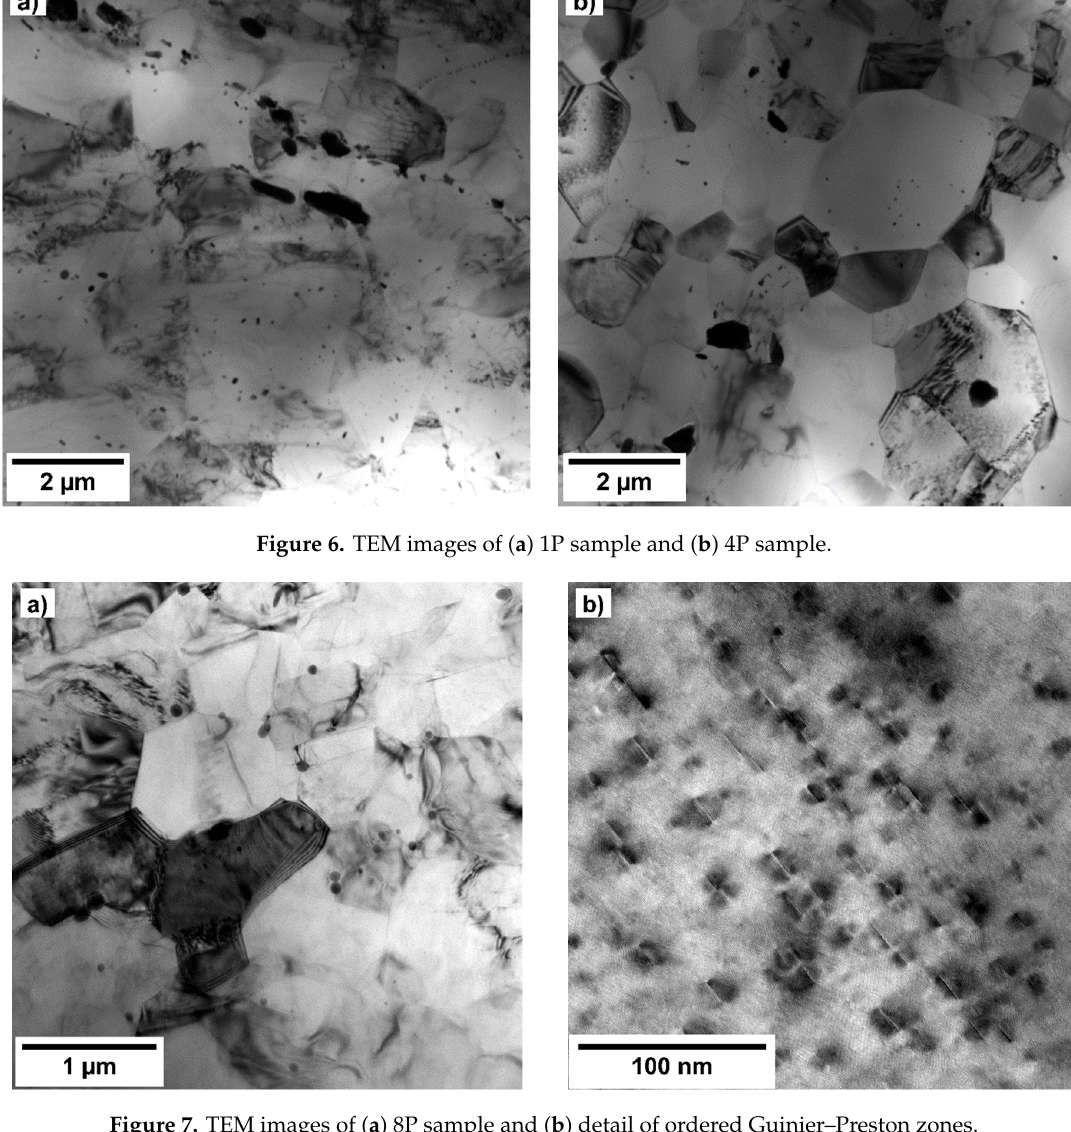
Figure 7. TEM images of ( a ) 8P sample and ( b ) detail of ordered Guinier–Preston zones.